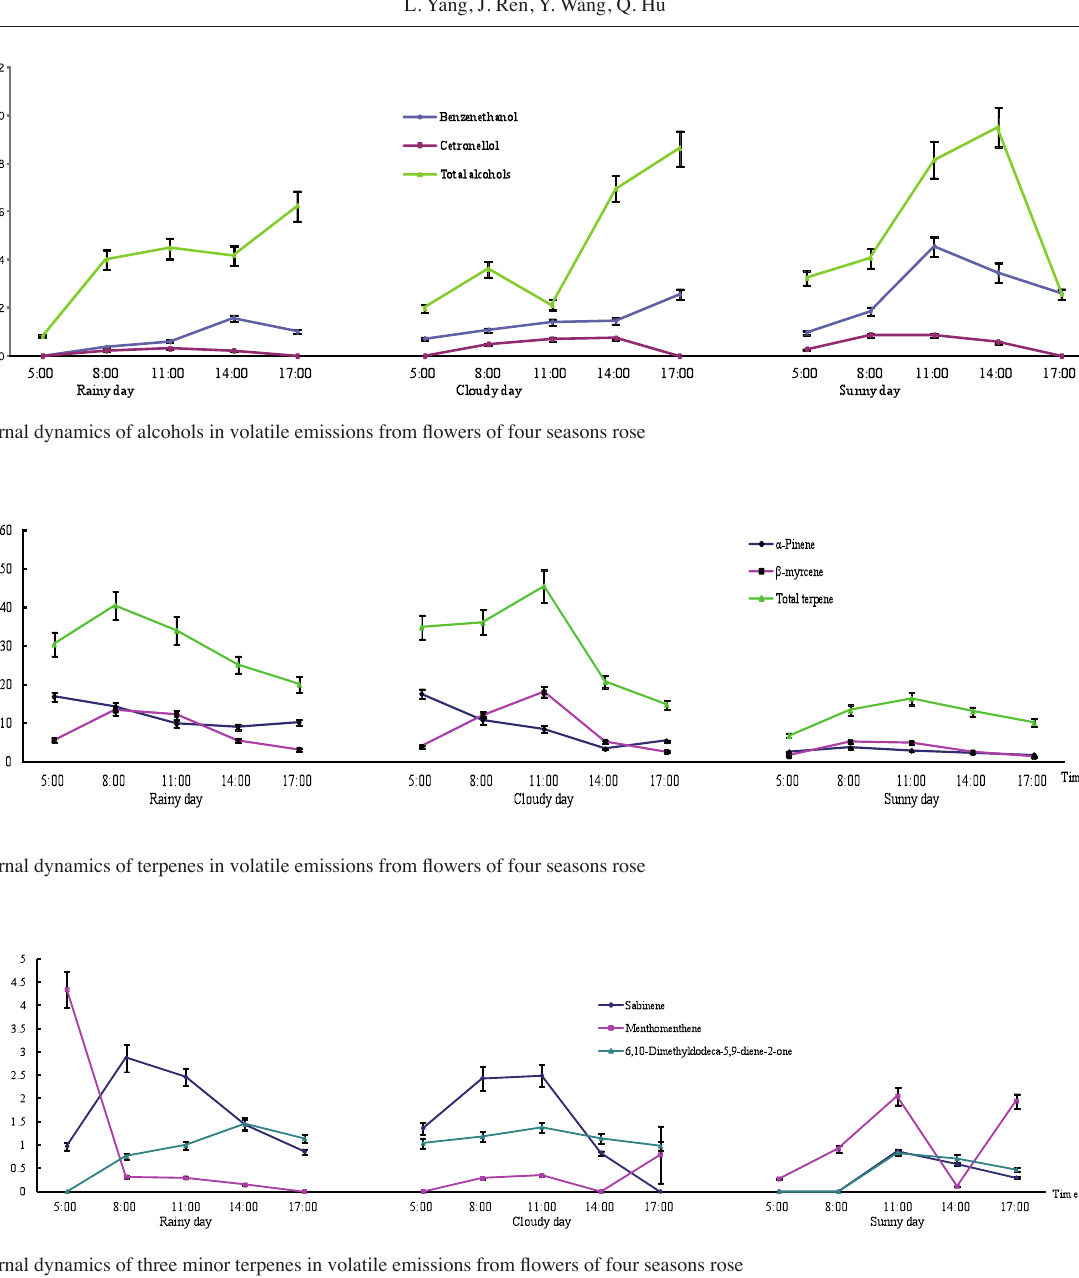
Fig. 6: Diurnal dynamics of three minor terpenes in volatile emissions from flowers of four seasons rose